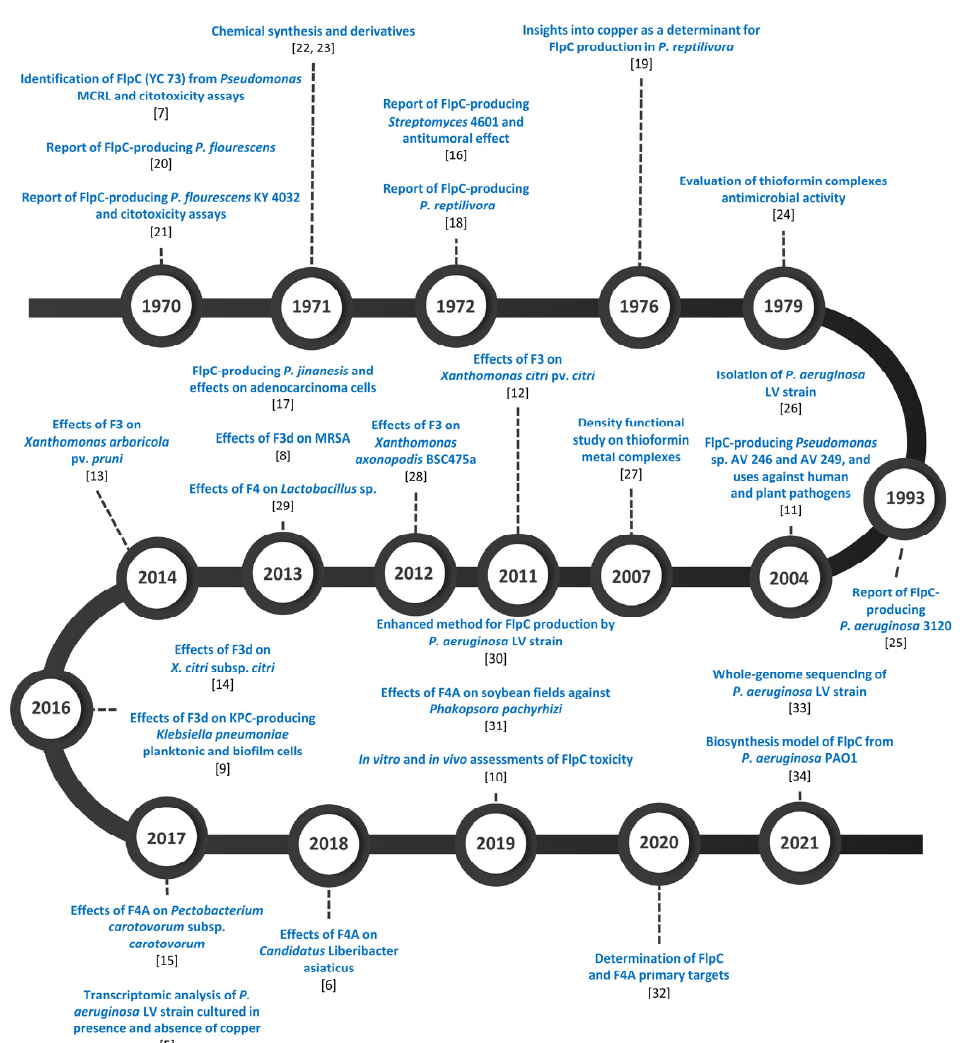
Figure 1. The timeline of studies related to Fluopsin C research. FlpC [bis( N -methylthioformohydroxamate)Cu(II)] is a compound with low- molecular-weight (~243,786 g·mol − 1 ), produced in the secondary metabolism of a few species of Pseudomonas and one Streptomyces (Table 1) [6,7,16]. Table 1. List of Fluopsin C-producing bacteria.